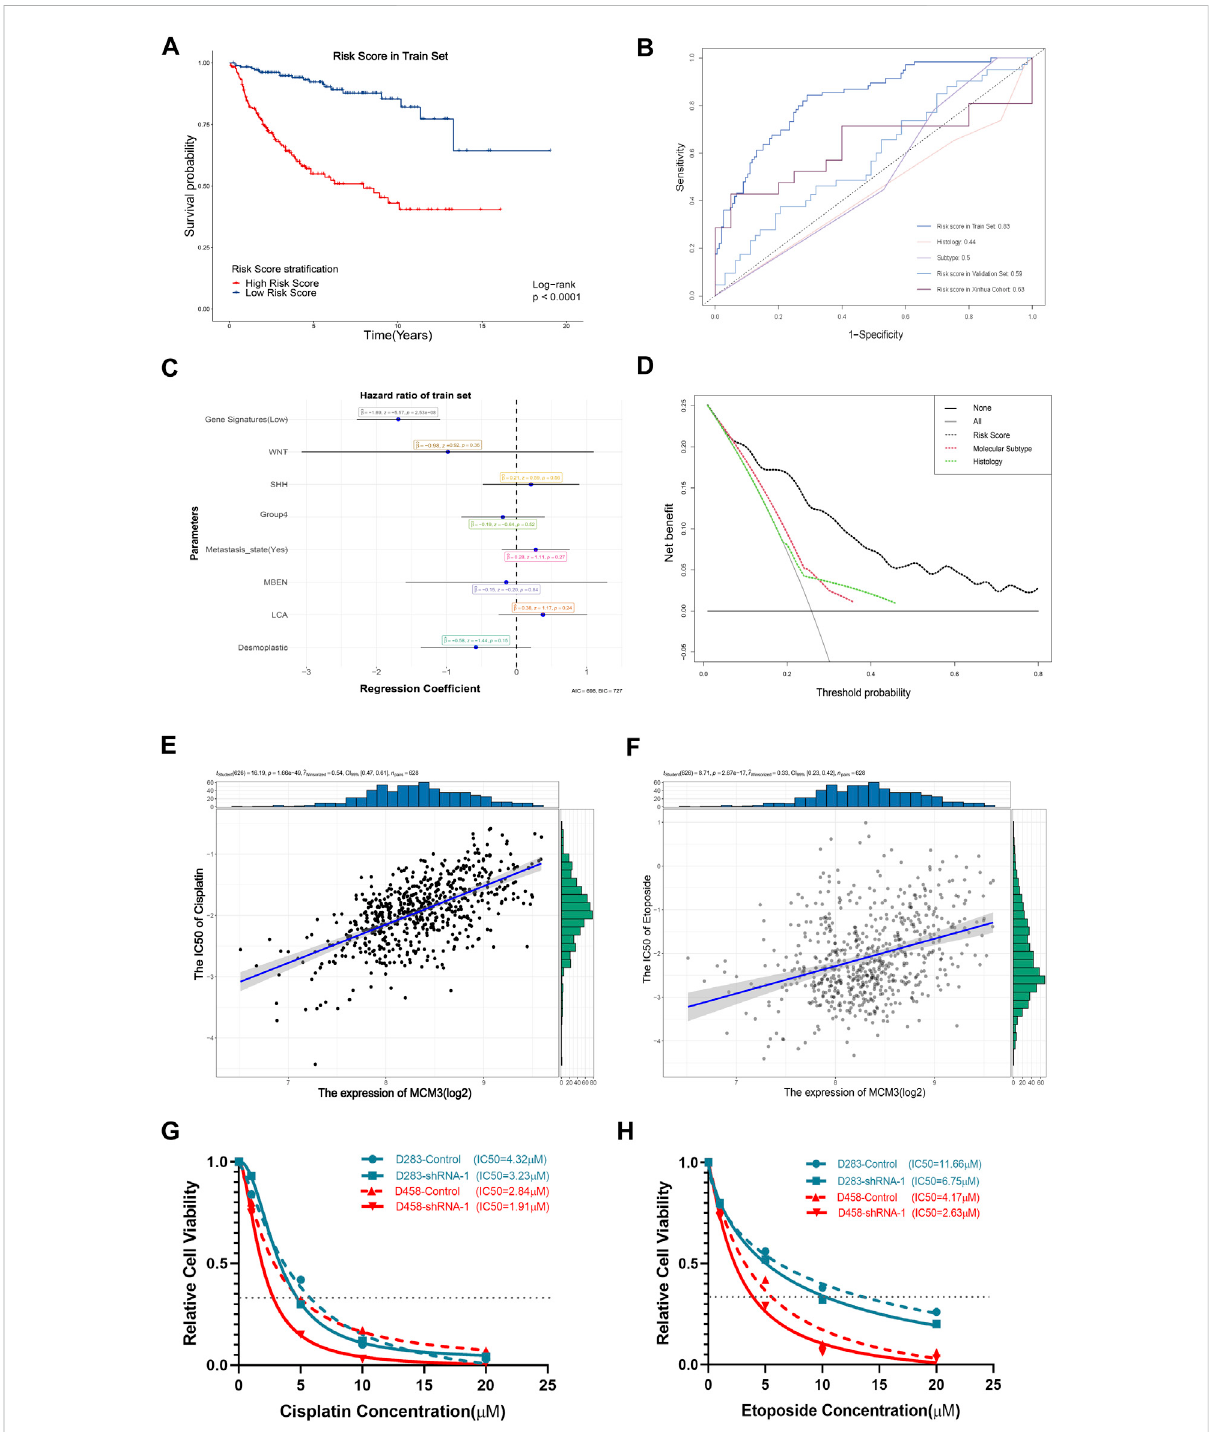
FIGURE 7 Signi fi cant association of the gene signature based on MCM3-related genes with OS (A) . The AUC values of the training set, internal validation set, and our cohort are higher than those for histological classi fi cation and molecular subtyping (B) . The forest plot showed that the gene signature wastheonlyindependentfactor (C) .DCAdemonstratingthebetterperformanceoftheriskscorecomparedtothecurrenthistological classi fi cation andmolecularsubtyping (D) .PositiveexpressionofMCM3expressionwithsensitivitytoetoposide (E) andcisplatin (F) .DecreasedIC 50 valuesof cisplatin (G) and etoposide (H) in the sh-MCM3 groups in both D283 and D458 cell